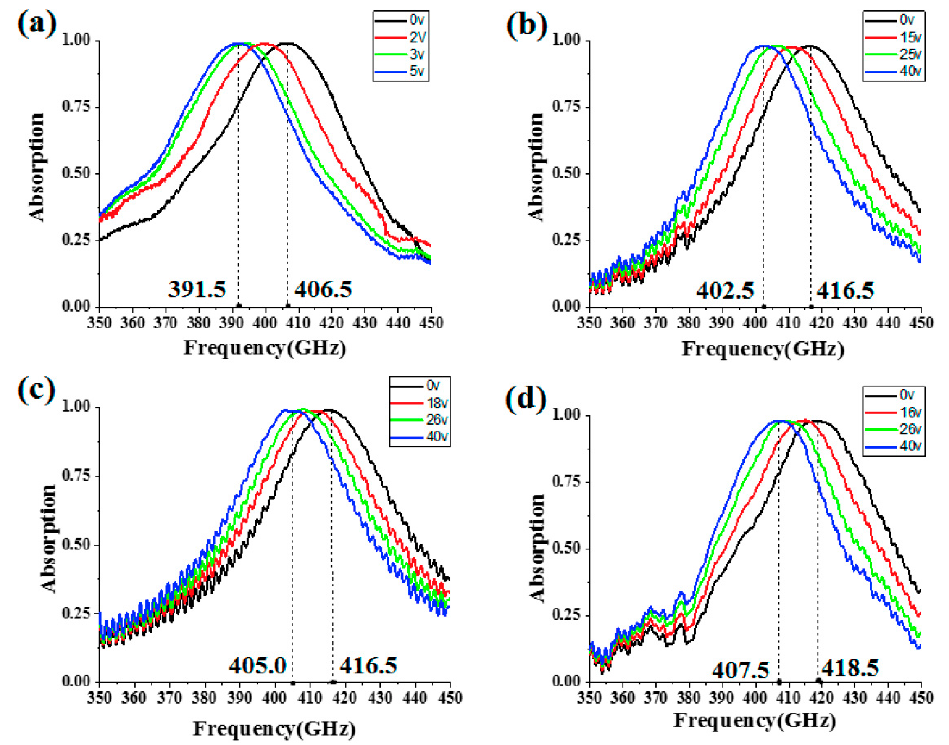
Figure 6. Measured absorption spectra of the PNLC based MA: ( a ) Without UV exposure; ( b ) with 30 min UV exposure; ( c ) with 60 min UV exposure; and ( d ) with 90 min UV exposure.